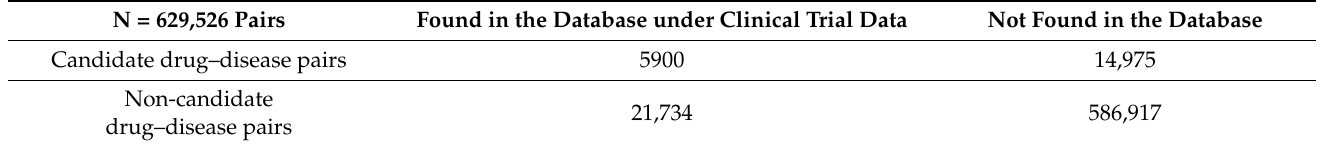
Table 2. Confusion table for validating the predictions with known drugs in clinical trial data. N = 629,526